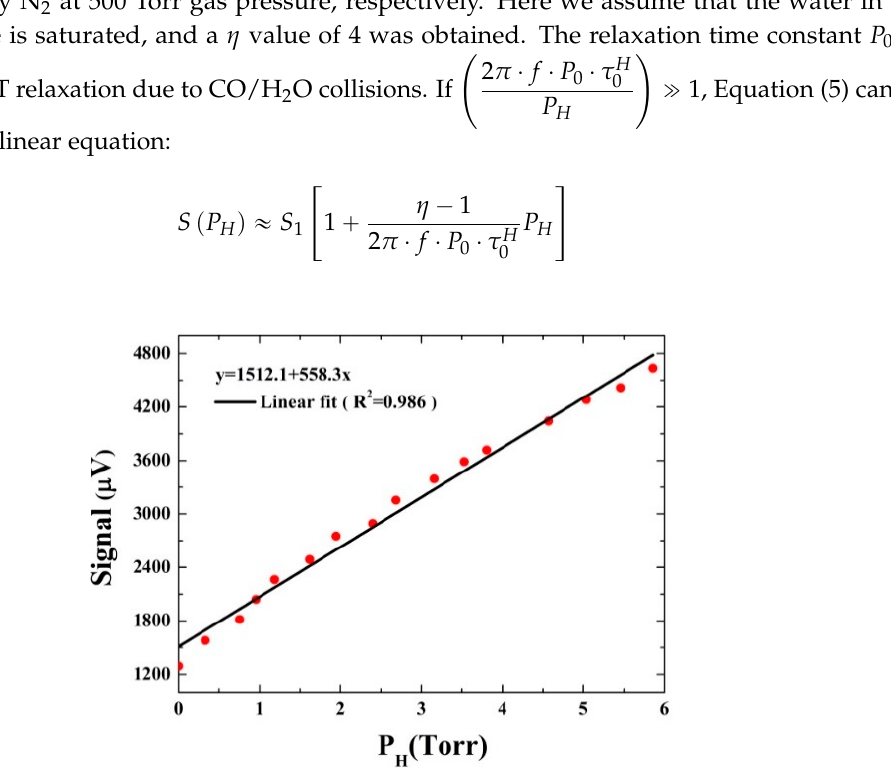
Figure 9. QEPAS signal (circles) as a function of H 2 O concentration for detecting CO in wet N 2 .